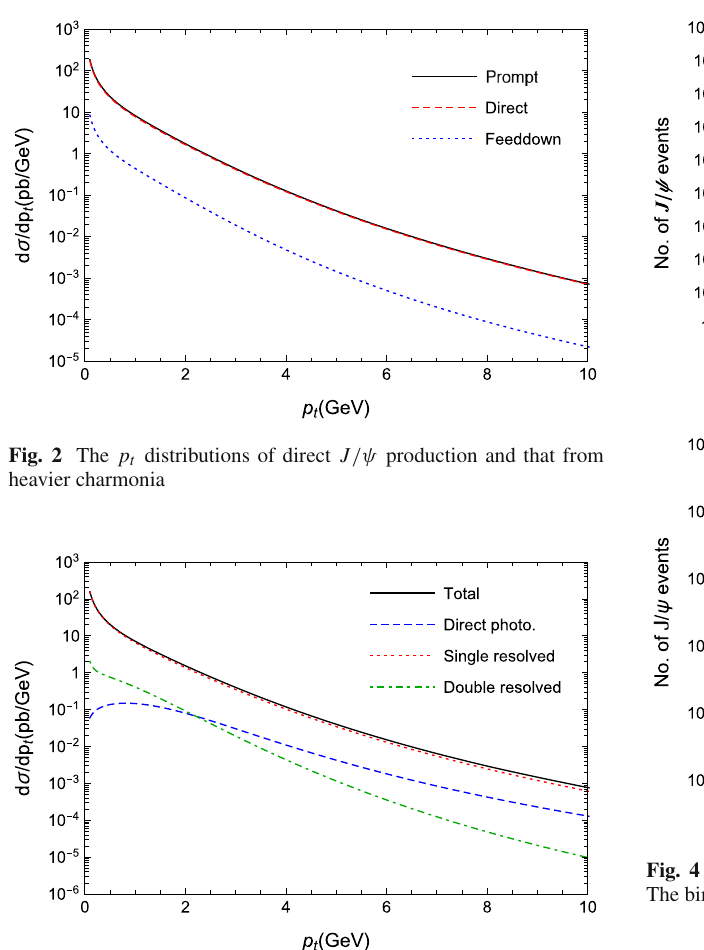
an upper bound for μ r = μ 0 / 2 , μ f = 2 μ 0 and a lower bound for μ r = 2 μ 0 , μ f = μ 0 / 2, as shown by light gray